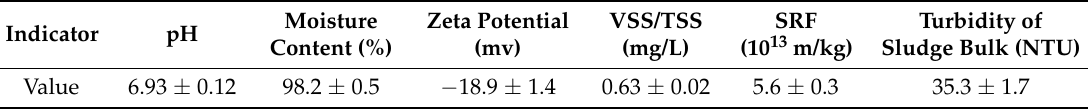
Table 1. Characteristics of the initial sludge without flocculant addition.